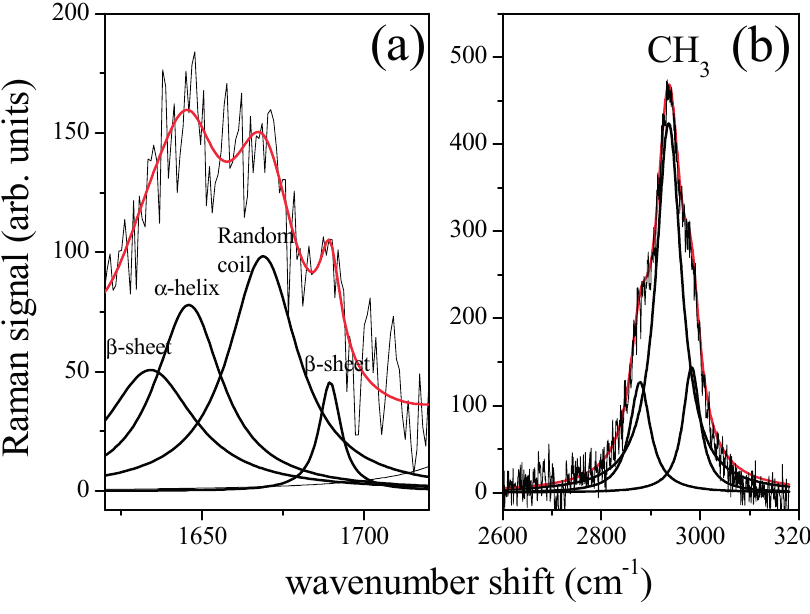
Figure 3. Deconvolution of Raman spectrum of control PDL sample in the Amide I ( a ) and in the lipid CH 3 ( b ) spectrum region. Red line is the curve obtained by envelop of peaks obtained by the fit procedure.